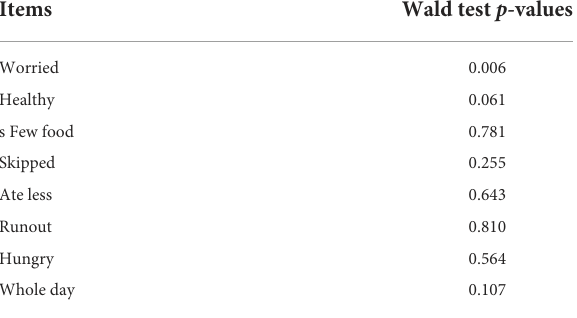
TABLE 7 Wald test applied on item parameters for sex